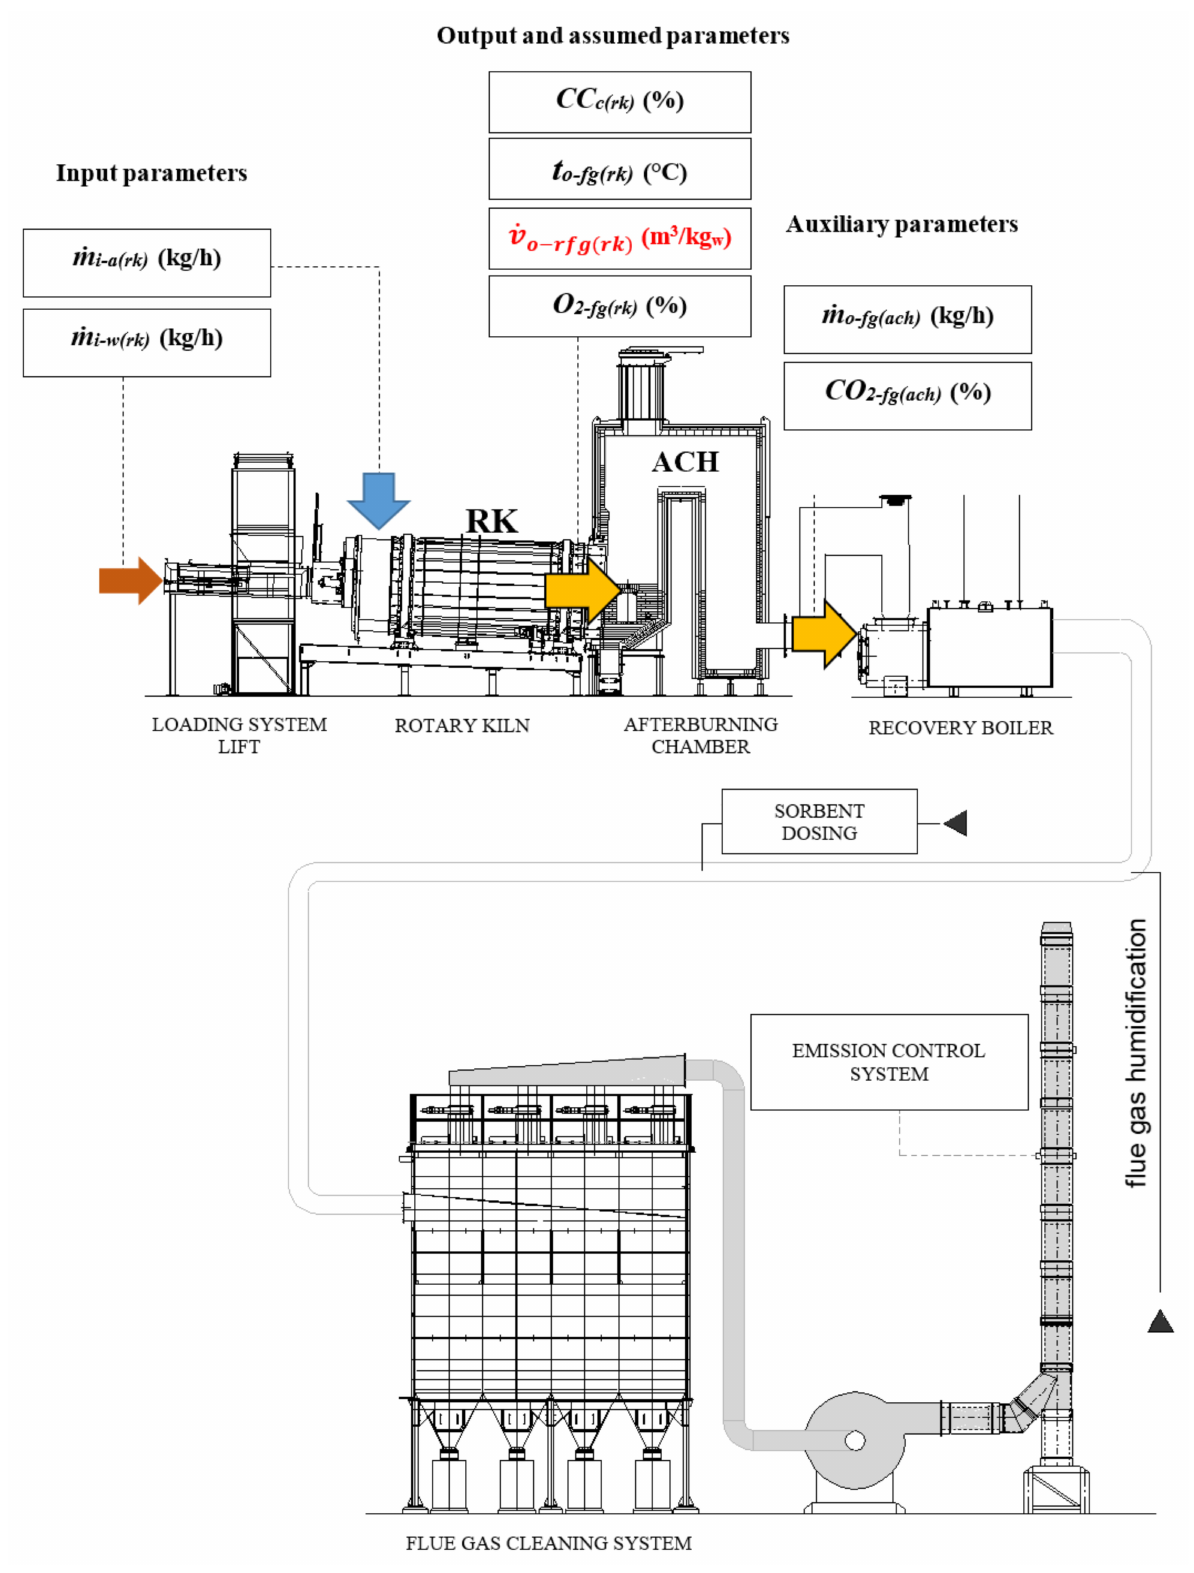
Figure 1. Input and output parameters of the computational